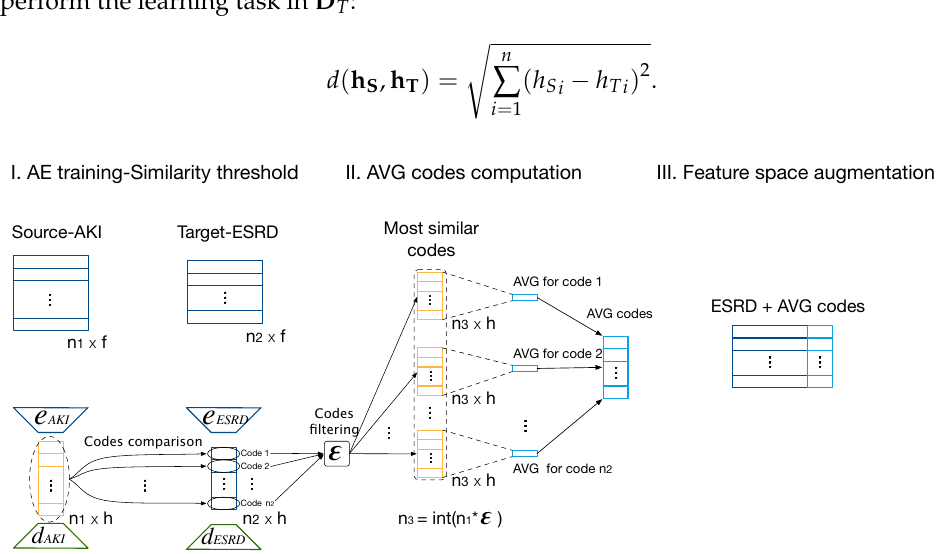
Figure 6. Scheme of proposed method for transferring AVG codes from D S to D T using